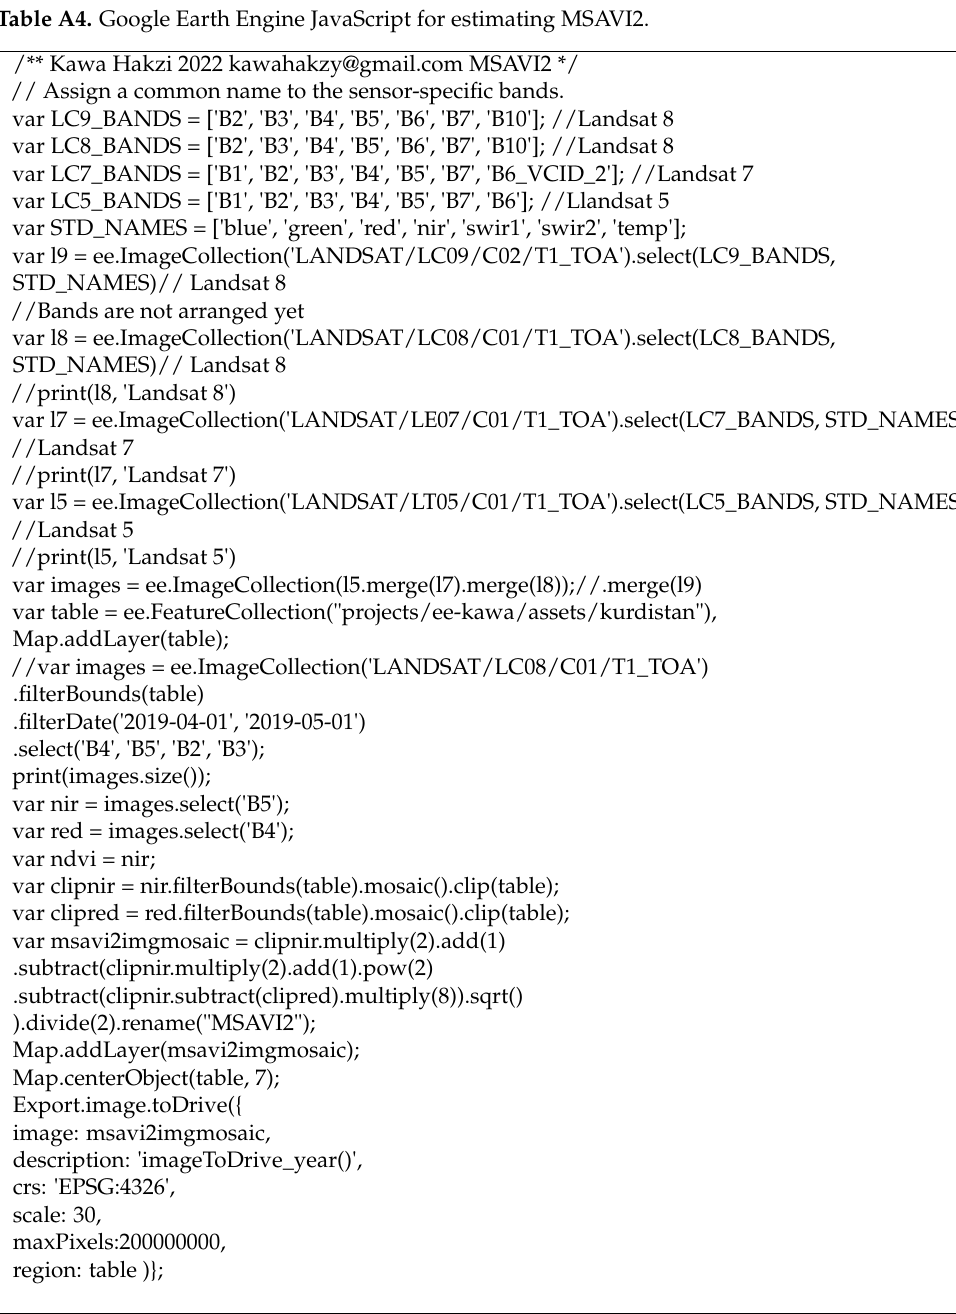
Table A4. Google Earth Engine JavaScript for estimating MSAVI2.